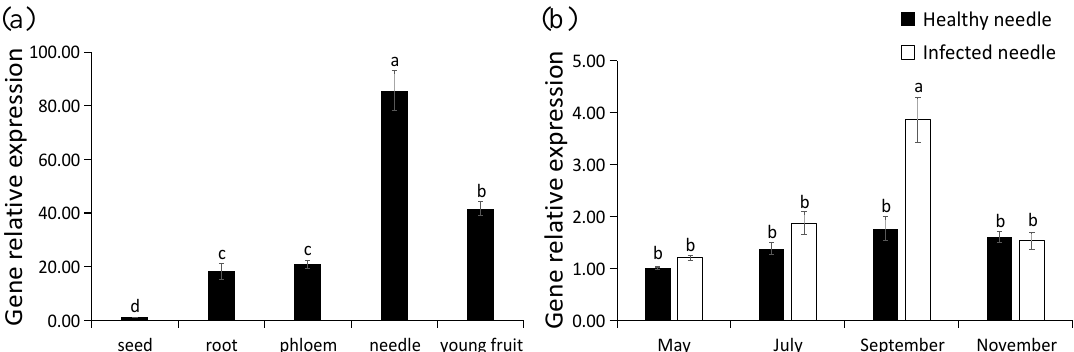
Figure 7. Transcription pattern of PaPAL . ( a ) Relative expression level of PaPAL in different tissues of P. asperata ; ( b ) relative expression level of PaPAL at different periods during pathogen infection. The data represent the mean values of three replicates ± standard errors (SEs). The different letters (a, b, c and d) on the SE line represent statistically significant differences at p ≤ 0.05 (Duncan´s multiple range test and T test, respectively).